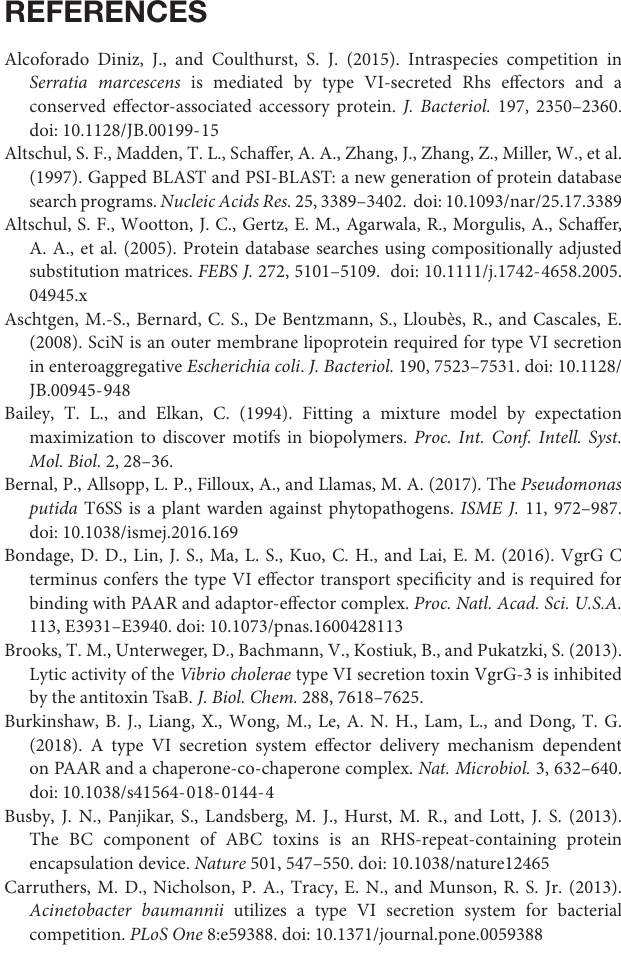
TABLE S1 | Characterized T6SS effector proteins from various bacterial species (excluding Acinetobacter effectors). FILE S1 | A. baumannii strains used in this study, amino acid sequence of the T6SS Hcp, TssM and PAAR proteins, and overall presence or absence of the core T6SS locus.